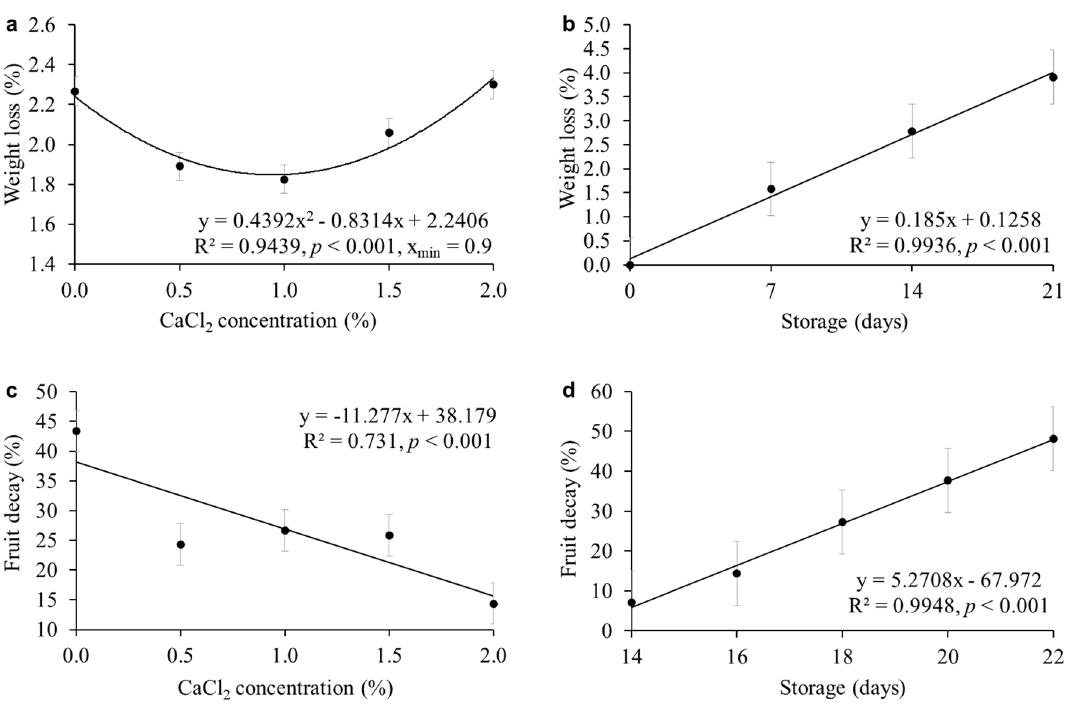
Figure 3. Weight loss ( a , b ) and fruit decay ( c , d ) in ‘Roxo de Valinhos’ fig fruits as a function of CaCl 2 concentrations and storage days at 5 ± 1 °C and 90–95% R.H. Bars symbolise standard errors (n = 4).